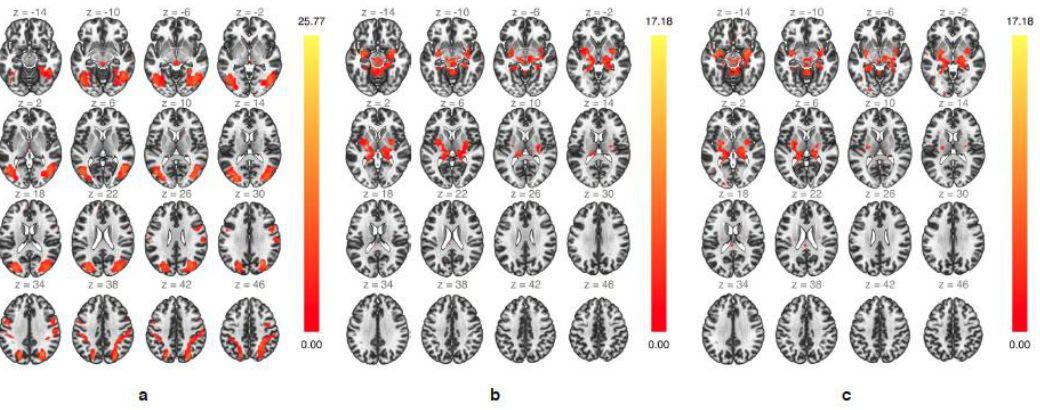
Figure 3. Group-independent component analysis (ICA) showing highly functionally-connected networks involving mesencephalic areas during up emotion regulation ( a , b ) and during down emotion regulation ( c ).